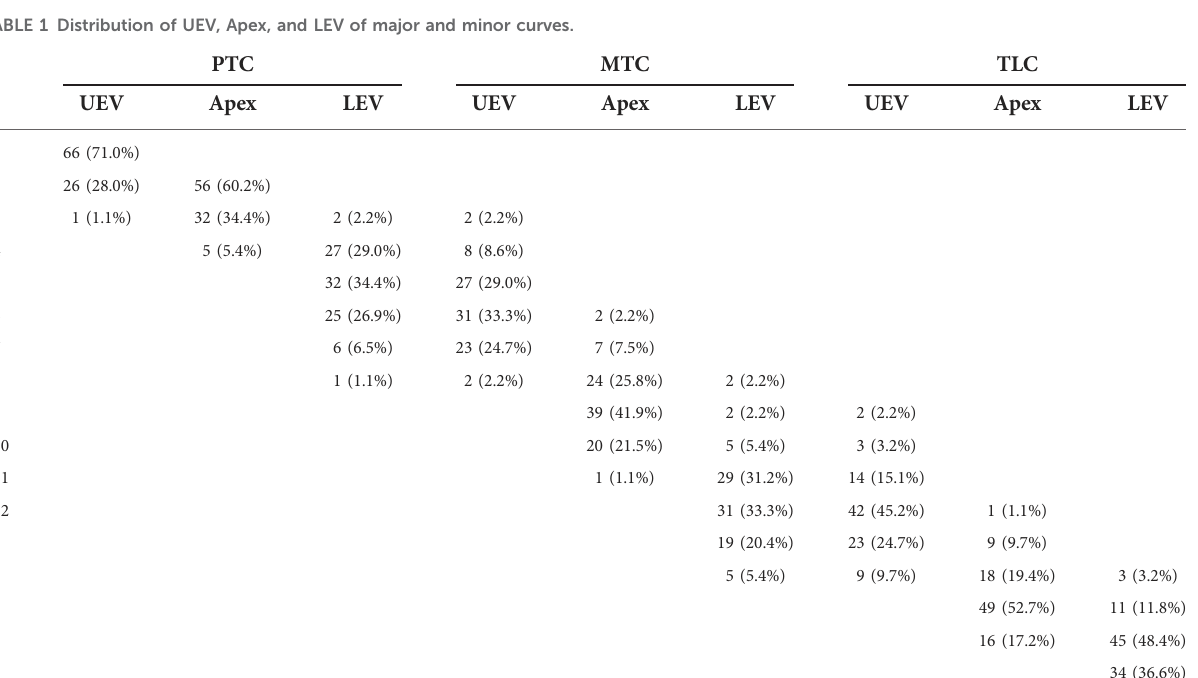
TABLE 1 Distribution of UEV, Apex, and LEV of major and minor